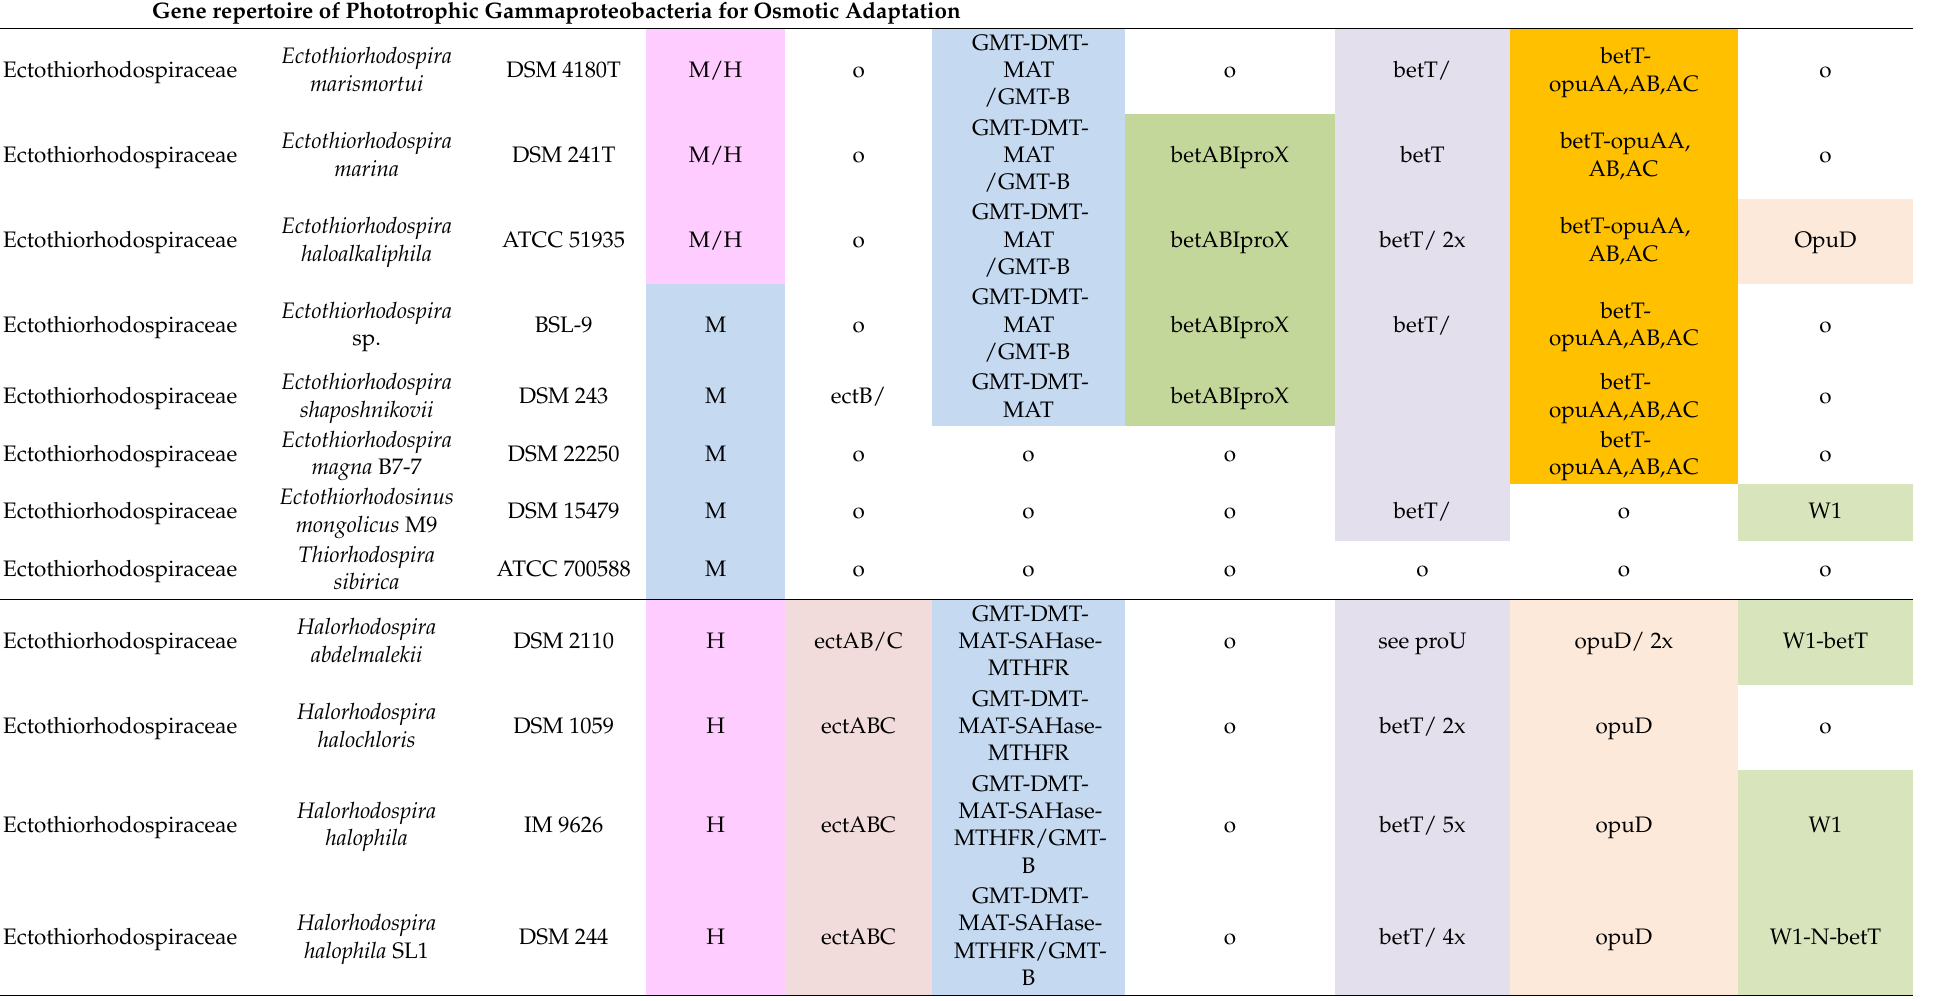
Gene repertoire of Phototrophic Gammaproteobacteria for Osmotic